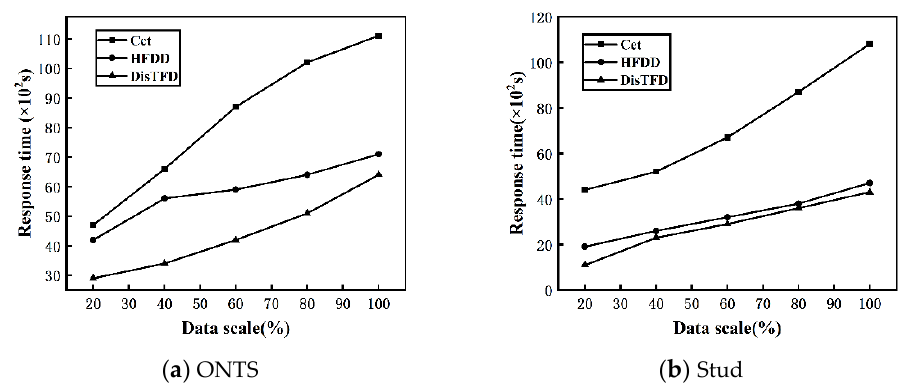
Figure 8. ( a ) Response time at different data scale (ONTS) ( b ) Response time at different data scale (Stud).